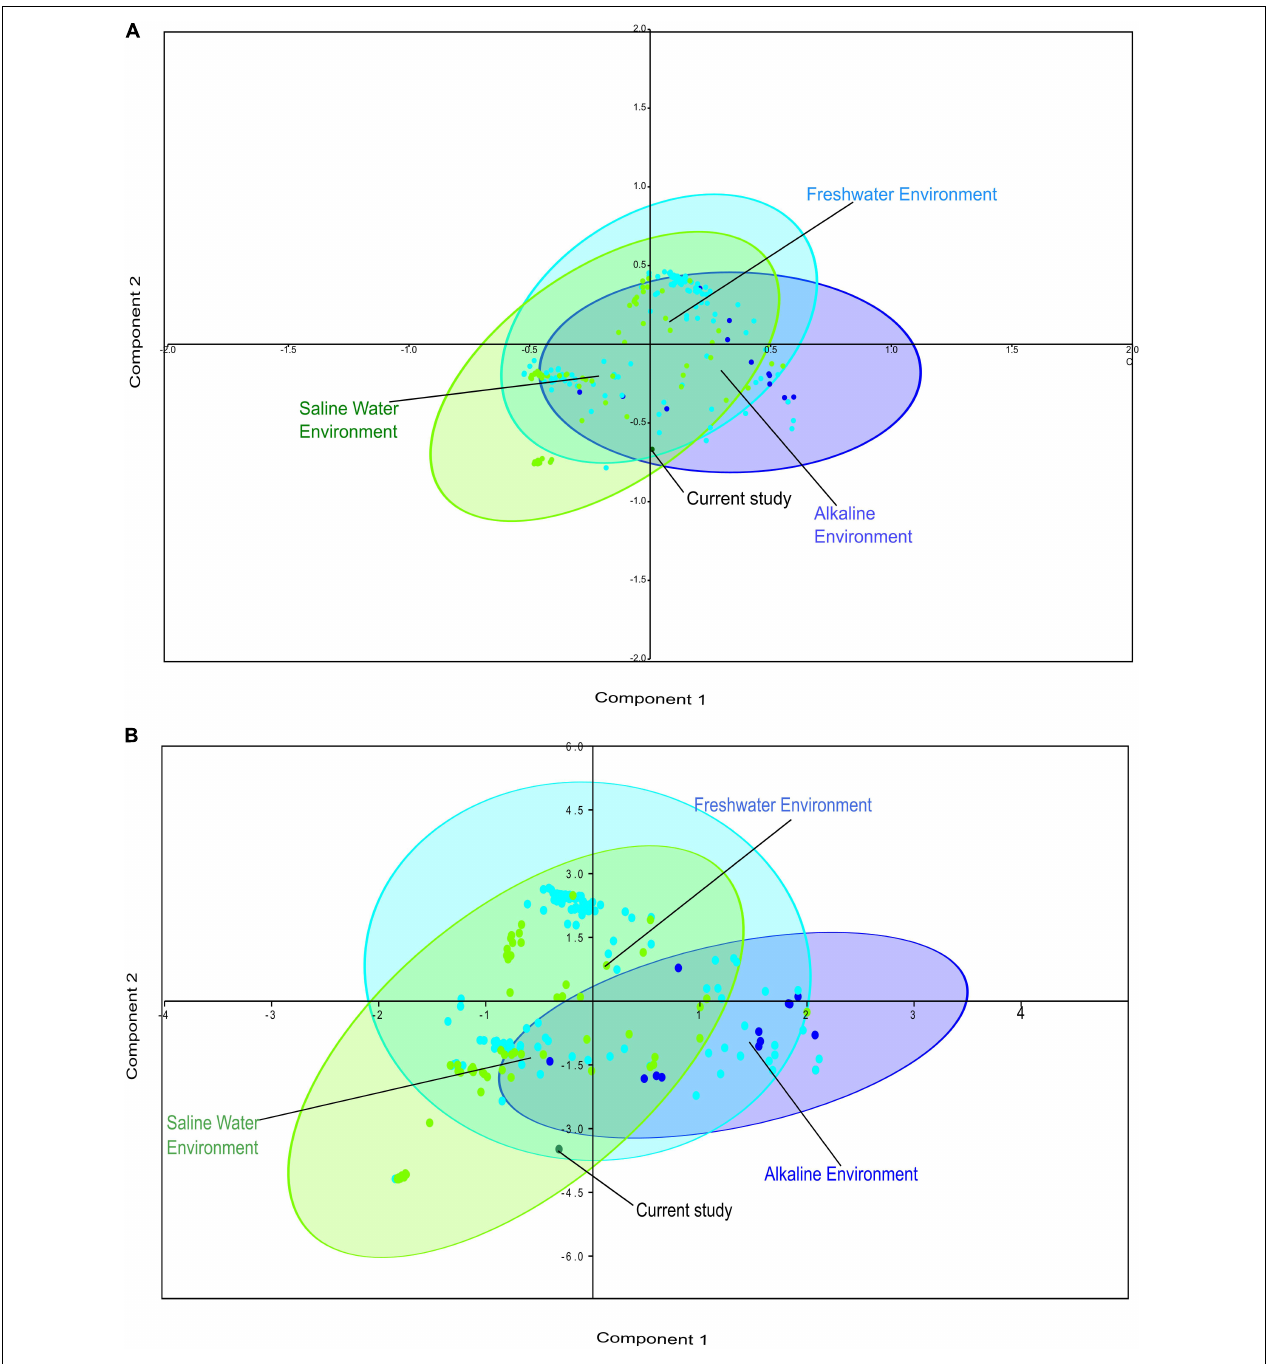
FIGURE 2 | Principal component analysis (PCA) of the diverse metagenomes with rRNA-based taxonomic features. Principal component analysis showing the clustering of the freshwater, alkaline water, and saline water metagenomes with taxonomic features identified at the phylum level of taxonomic hierarchy (A) and class level of taxonomic hierarchy (B)